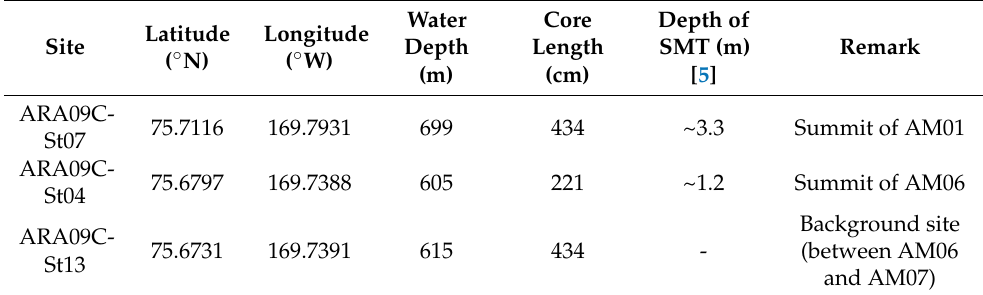
Table 1. Summaries of location, water depth, total core length, and depth of the SMT [5] in each site from the ARA09C